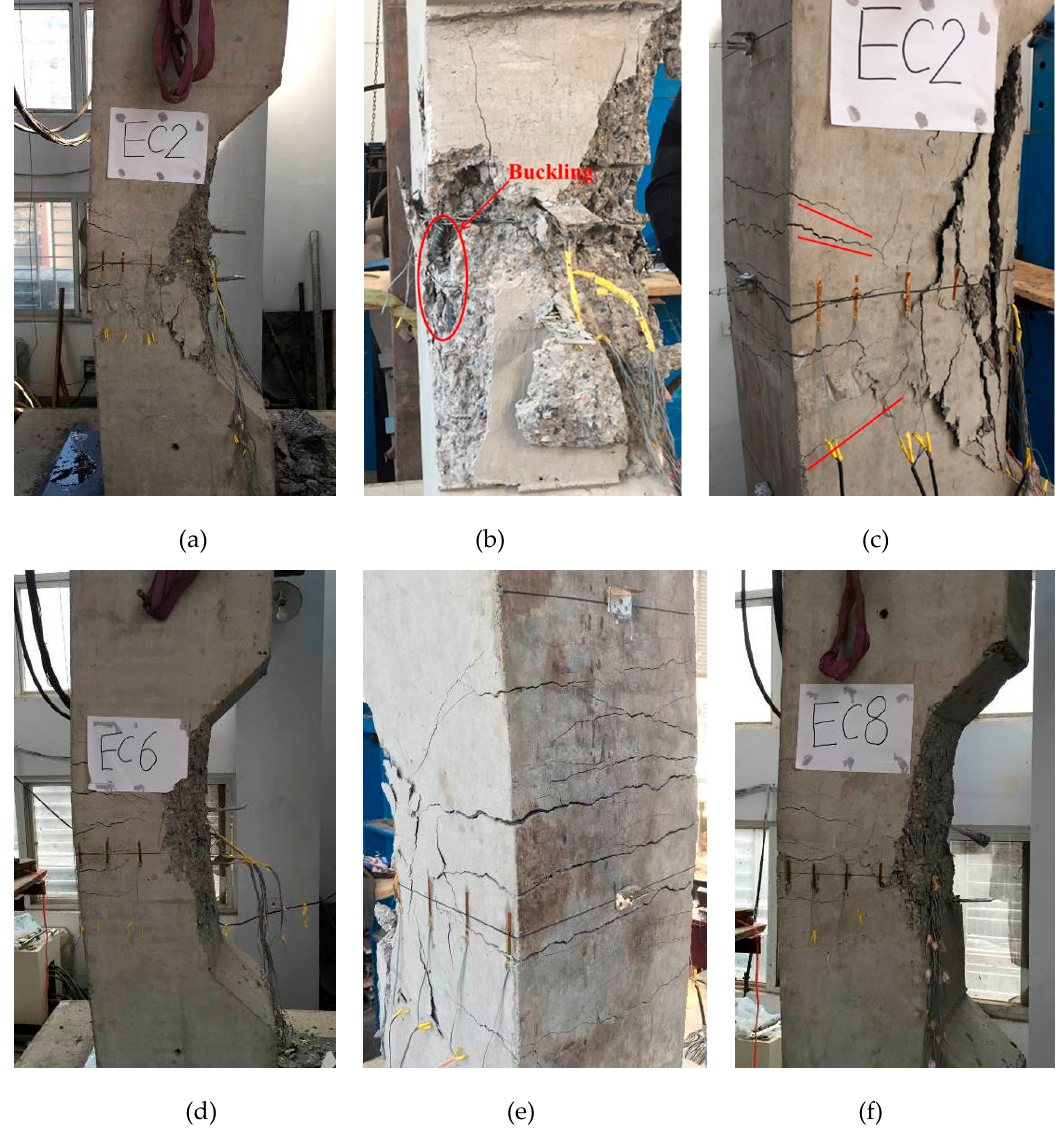
Figure 4. Failure patterns of the columns. ( a ) Final failure mode; ( b ) buckling of longitudinal bar; ( c ) tensile cracks; ( d ) final failure mode of EC6; ( e ) major cracks; ( f ) final failure mode of EC8.